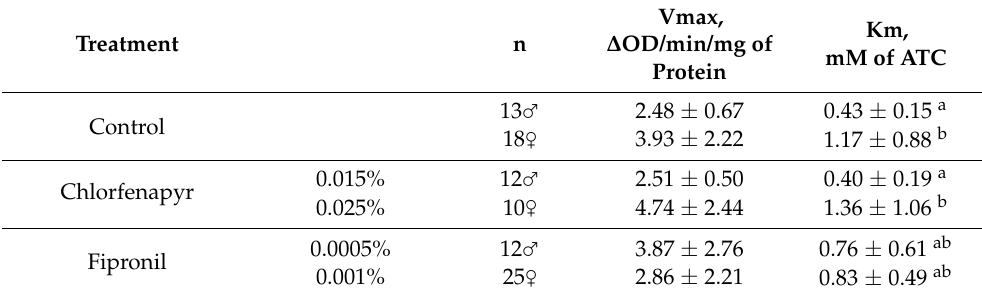
Table 2. Kinetic parameters of acetylcholinesterase in adults of M. domestica (M ± SD) *.